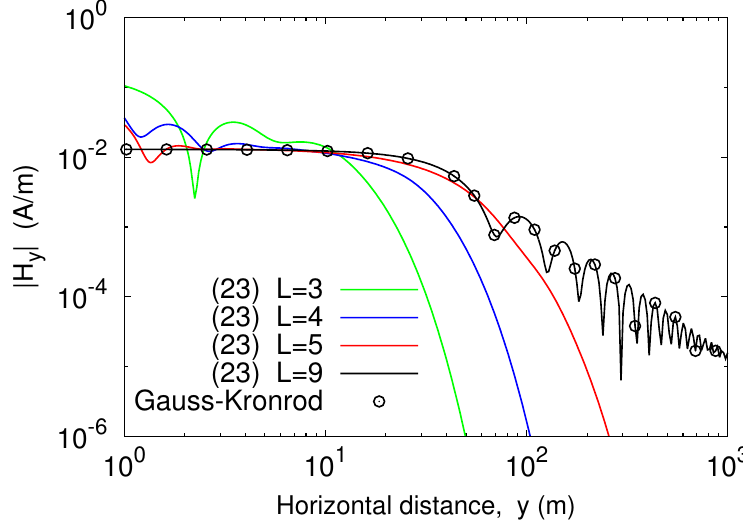
Figure 2. Amplitude of H y against the horizontal distance from the line